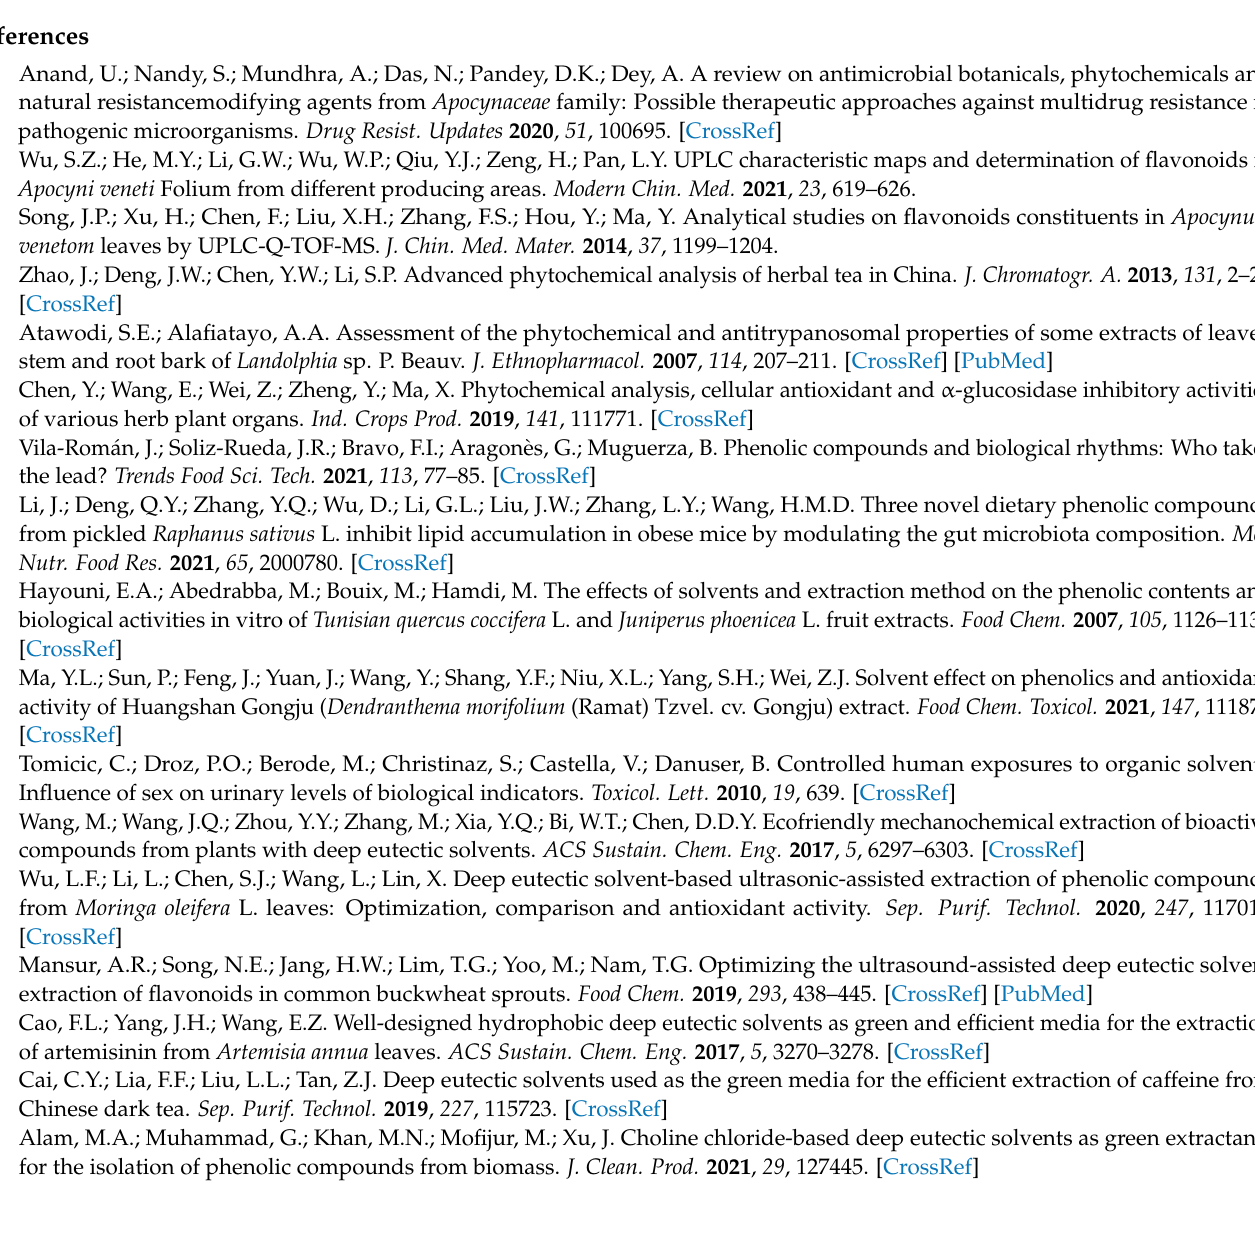
DLT extracts. Table S1: Experimental design and results of full factorial design experimental; Table S2: Independent process variables with experimental ranges and levels of response surface